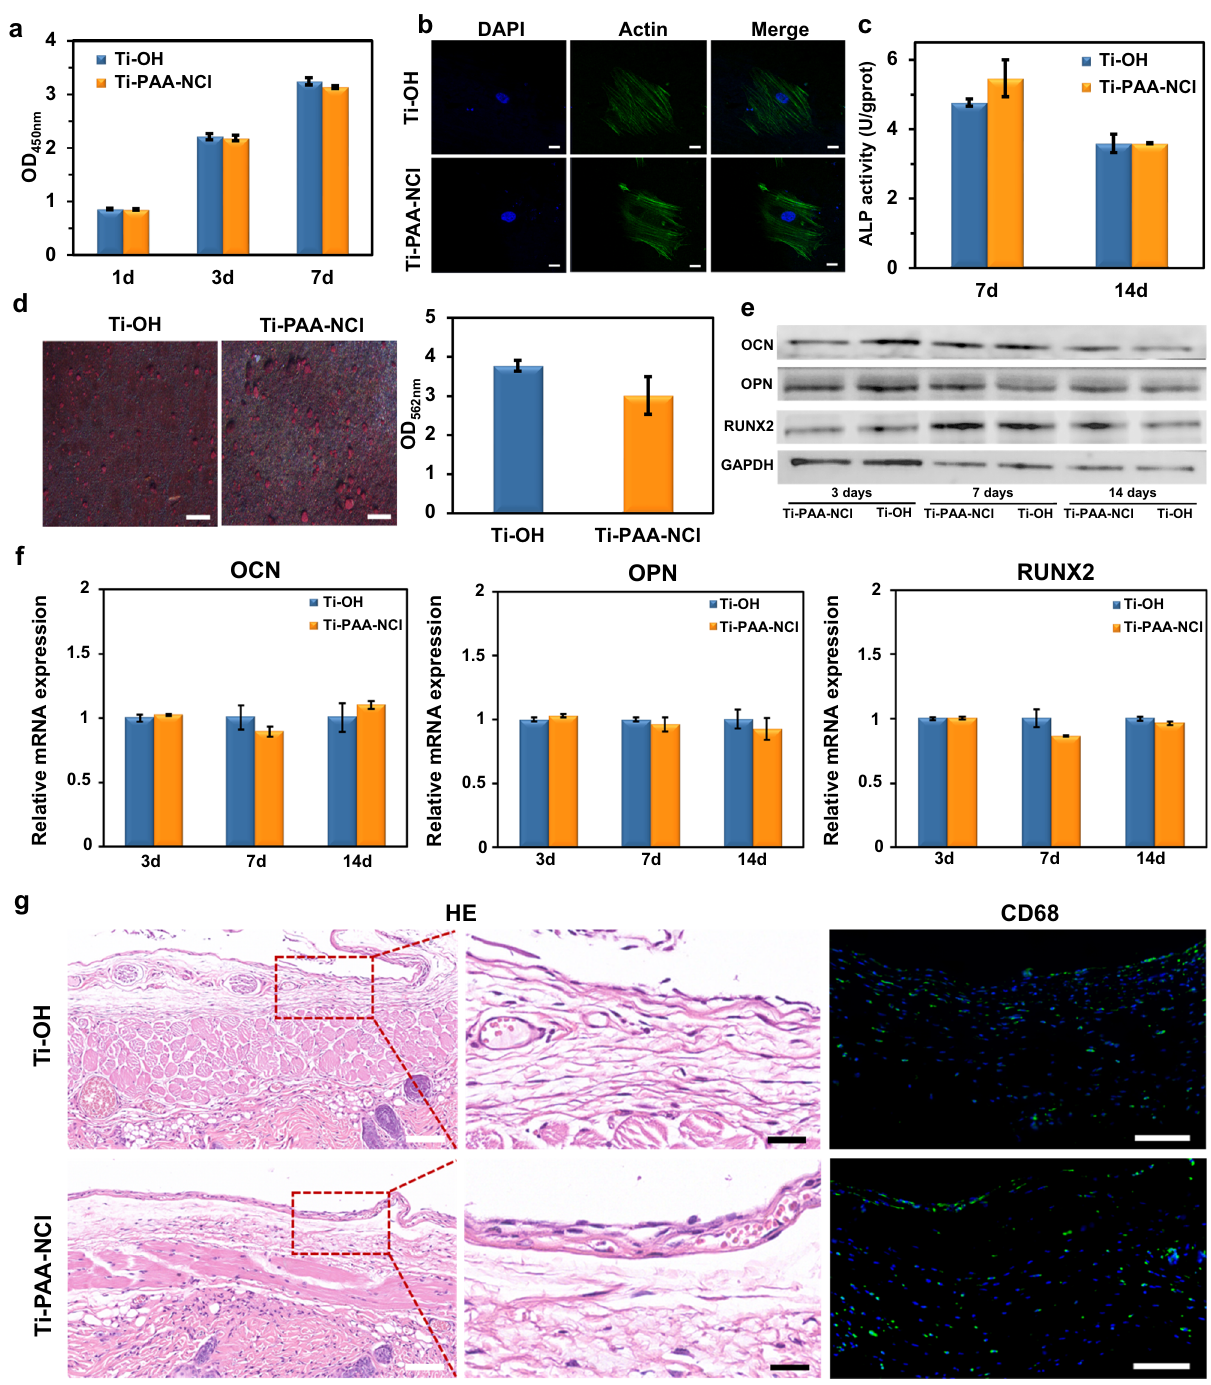
Fig. 5 Biocompatibility assessments. a CCK-8 assay about the proliferation of MC3T3-E1 preosteoblasts cultured on Ti-OH and Ti-PAA-NCl after cells were cultured for 1, 3 and 7 days ( n = 3; P = 0.673, 0.639 and 0.145 for 1, 3 and 7 days compared with Ti-OH, respectively; Student ’ s t test). b